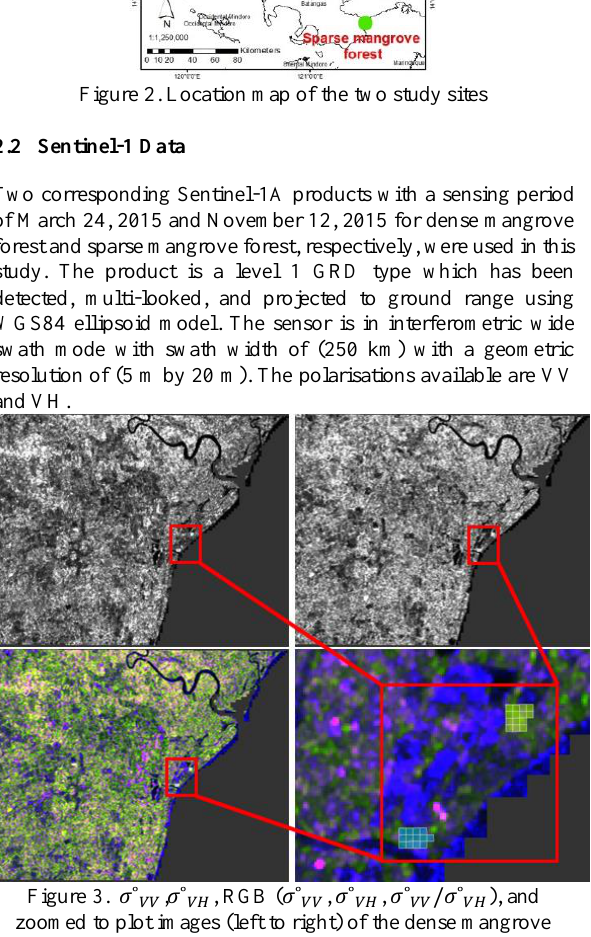
Figure 3. 𝜎˚ 𝑉𝑉 , 𝜎˚ 𝑉𝐻 , RGB ( 𝜎˚ 𝑉𝑉 , 𝜎˚ 𝑉𝐻 , 𝜎˚ 𝑉𝑉 /𝜎˚ 𝑉𝐻 ), and zoomed to plot images (left to right) of the dense mangrove forest